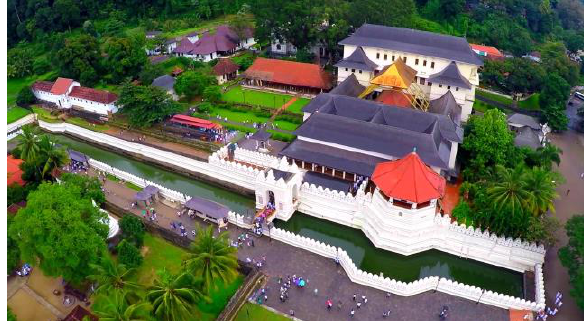
Fig. 1. The temple complex at